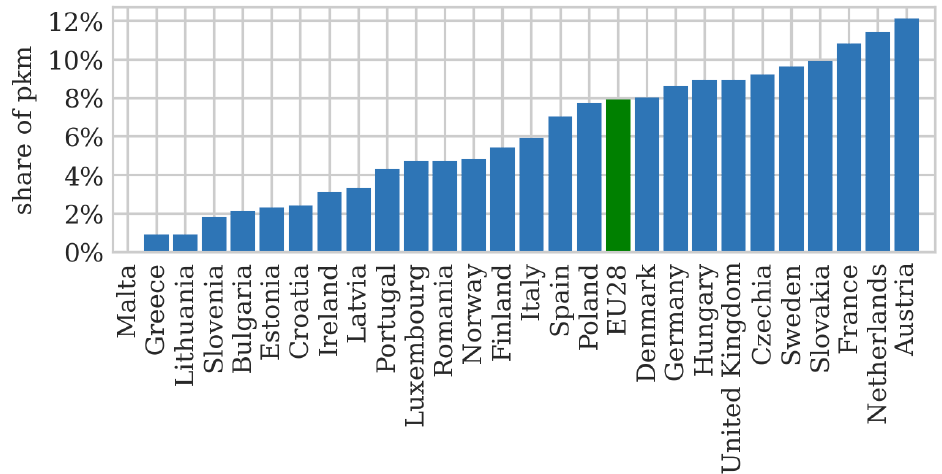
Figure 6. Modal share of railway transportation in passenger transport for selected European countries in 2017. Own study based on data from [75].